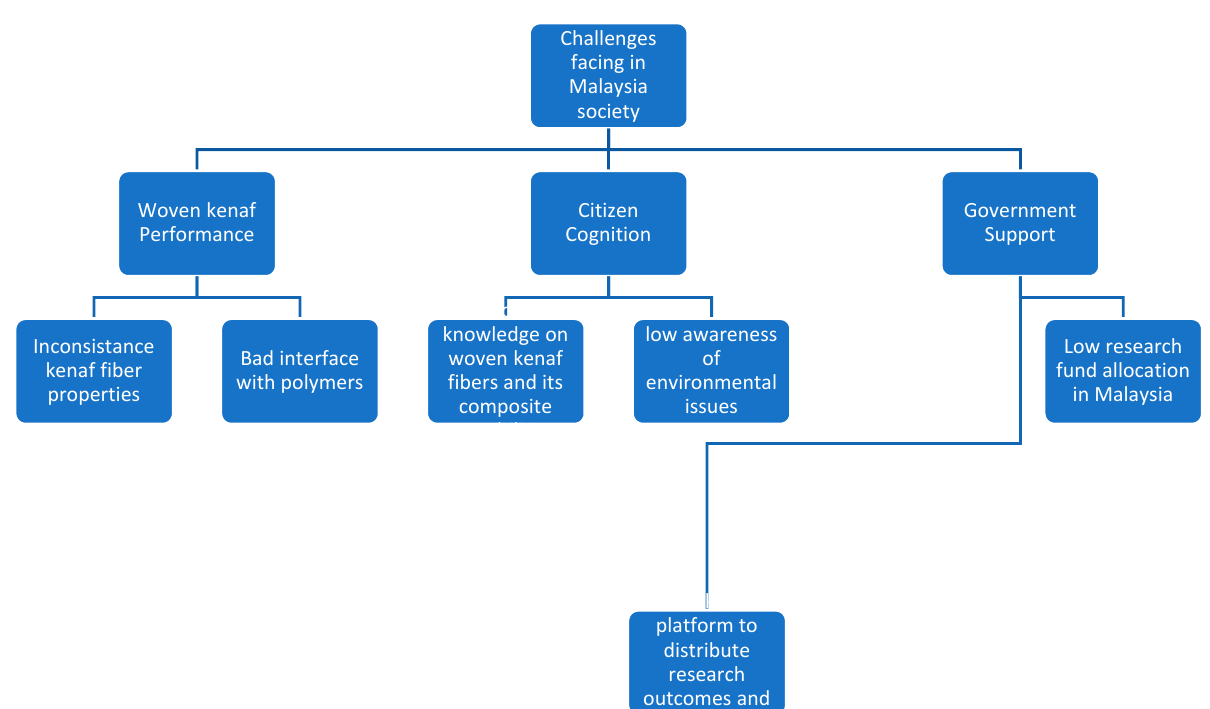
Figure 9. The challenges faced by woven kenaf thermoset polymer composites in Malaysia. Woven kenaf fiber is similar to other natural fibers, its properties are mainly governed by the chemical components in the fiber. However, high degrees of inconsistency were found in the chemical components among individual kenaf fibers, meaning that the properties vary from fiber to fiber. This has led manufacturers to step away from selecting woven kenaf fiber as a substitute for synthetic fibers, which are identical in all aspects.